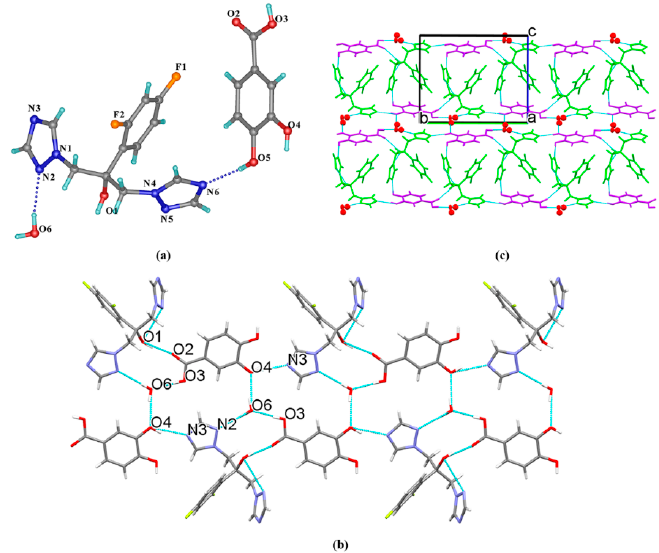
Figure 4. ( a ) Hydrogen-bonding interactions in an asymmetric unit; ( b ) the 2D hydrogen-bonded motifs six-member cyclic unit composed of FLZ, 34DHB, and water molecules; ( c ) hydrogen-bonded 3D structure stabilized by water molecules and other weak contacts with water molecules in space- filled mode viewed down the crystallographic a-axis. a,b,c in subfigure ( c ) represents the three axes of the cell.